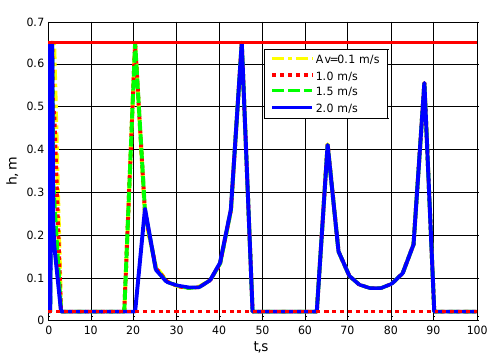
Figure 6. Diagrams of dependence   h t for several values of the amplitudes of the wind oscillations A V